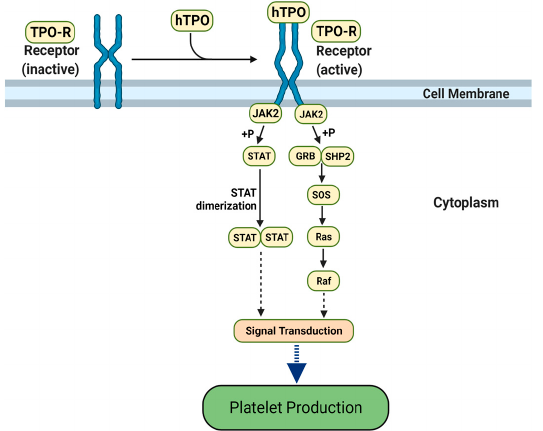
Figure 2. The hTPO pathway to induce platelet production. Simplified JAK ‐ STAT signaling path ‐ way in megakaryocytes where hTPO activates the TPO receptor and triggers signaling cascades that stimulate platelet production [60,61] . Created with BioRender.com (accessed on 12 August